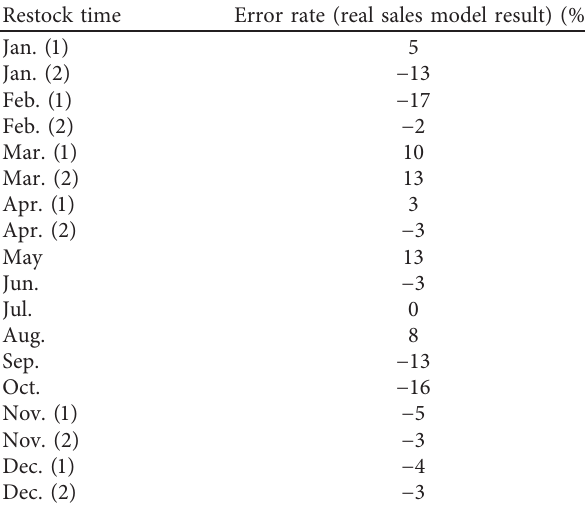
Figure 3: Drug replenishment process. Table 13: Model simulation results.